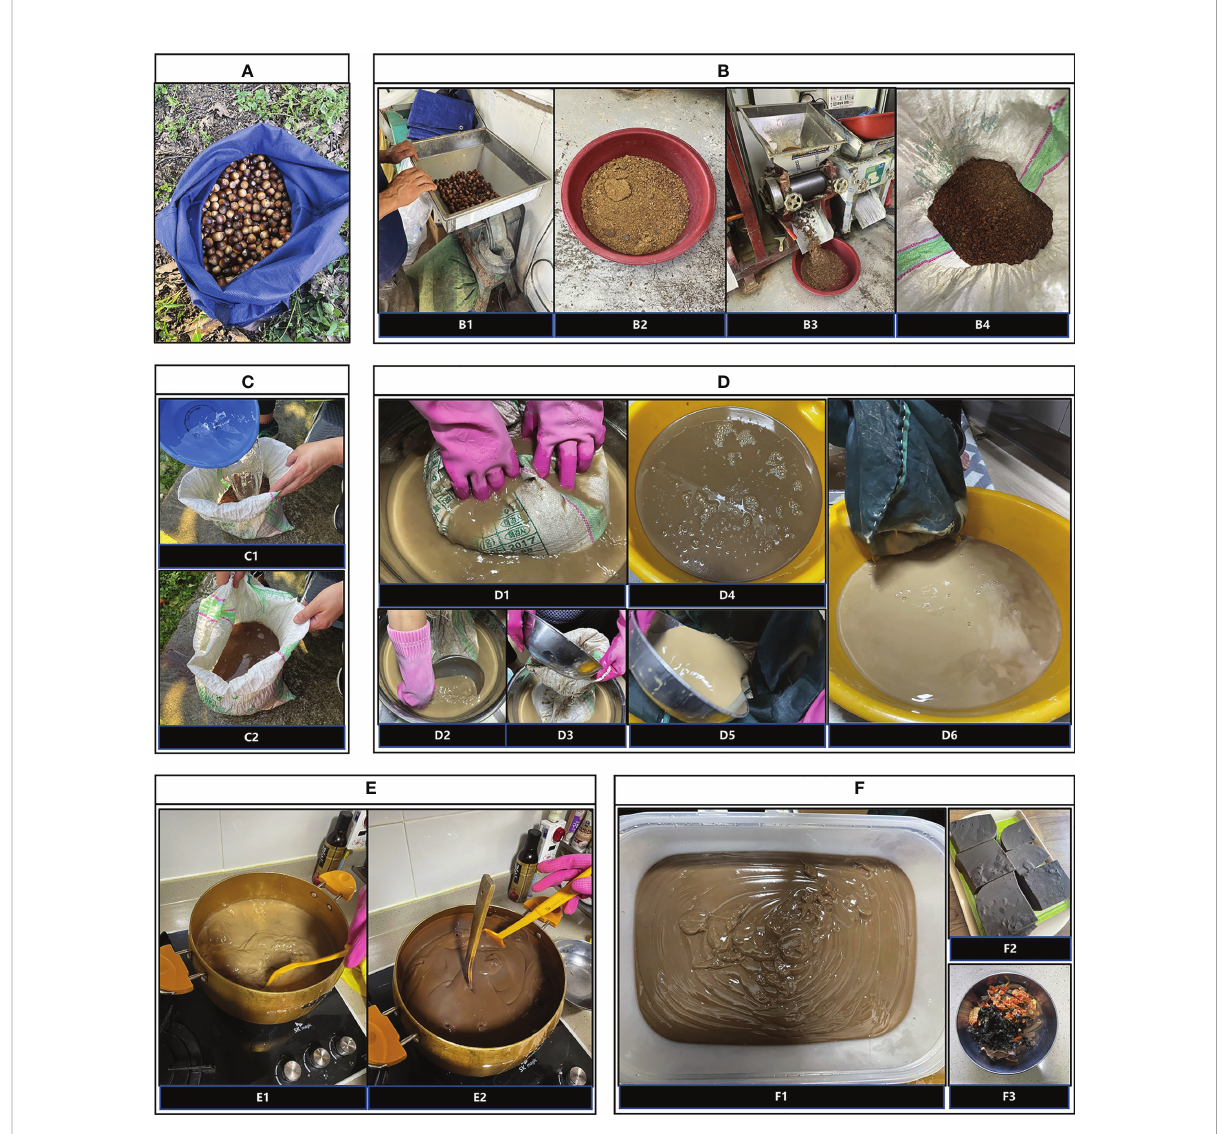
FIGURE 1 Ethnological study of ‘ mook-making ’ process in Chungcheongbuk-do, South Korea. (A) Collected acorns. (B) Grinding acorns using the modern crushing machines. B1. First grinding. B2. Acorn powder after the fi rst grinding. B3. Second grinding. B4. Acorn powder after the second grinding. (C) Rinsing and fi ltering the ground acorn powder repetitively. (D) Starch-shell separation to extract acorn starch. D1-D3. Kneading constantly. D4. Liquid after the fi rst fi ltering. D5. Pouring liquid into another bag for a second fi ltering. D6. Liquid after the second fi lter. (E) Boiling the acorn starch. E1. Acorn starch before boiling. E2. Acorn starch after boiling. (F) Solidi fi cation and serving. F1. 1,600ml acorn starch in a plastic mould. F2. Six mook blocks. F3.